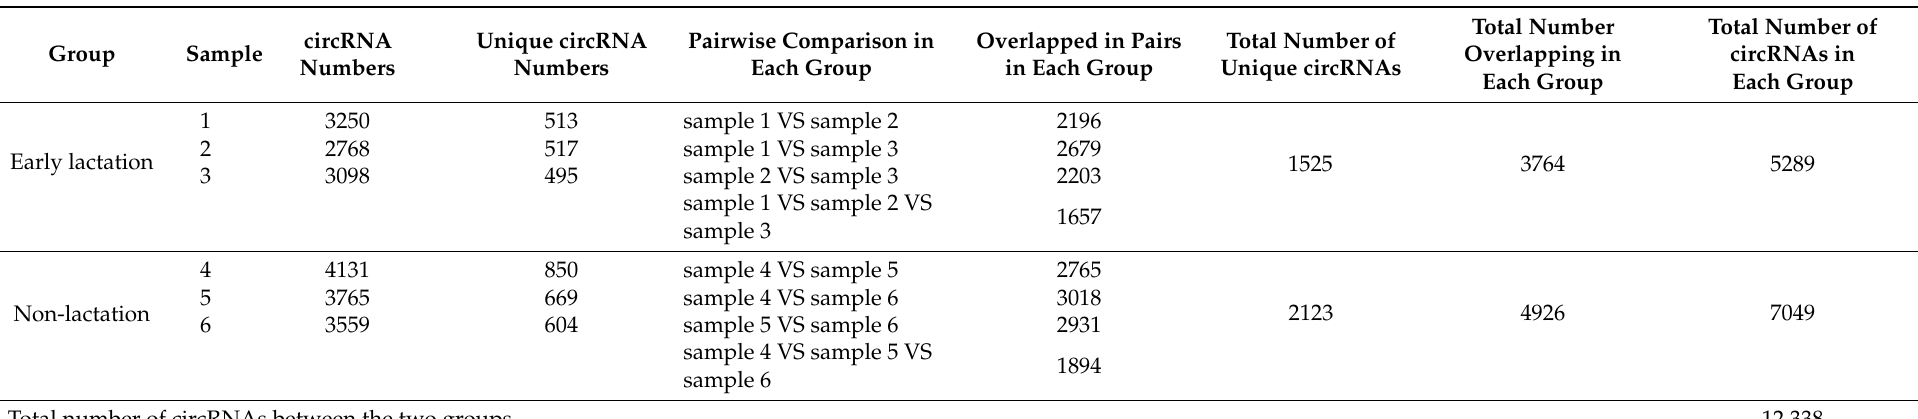
Table A2. The number of circRNAs between the two